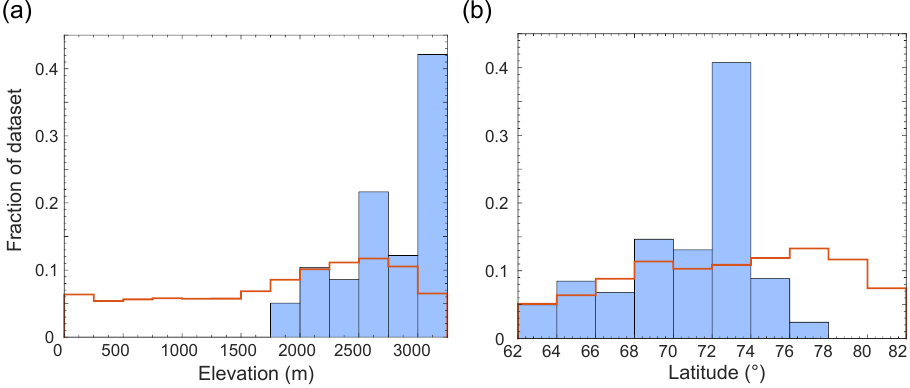
Figure 11. (a) Histogram showing the fraction of the accumulation subdataset by elevation. Red line is the fraction of elevations for the entire GrIS from CryoSat-2 DEM. (b) Histogram showing the fraction of the accumulation dataset by latitude. Red line is the fraction of latitudes for the entire